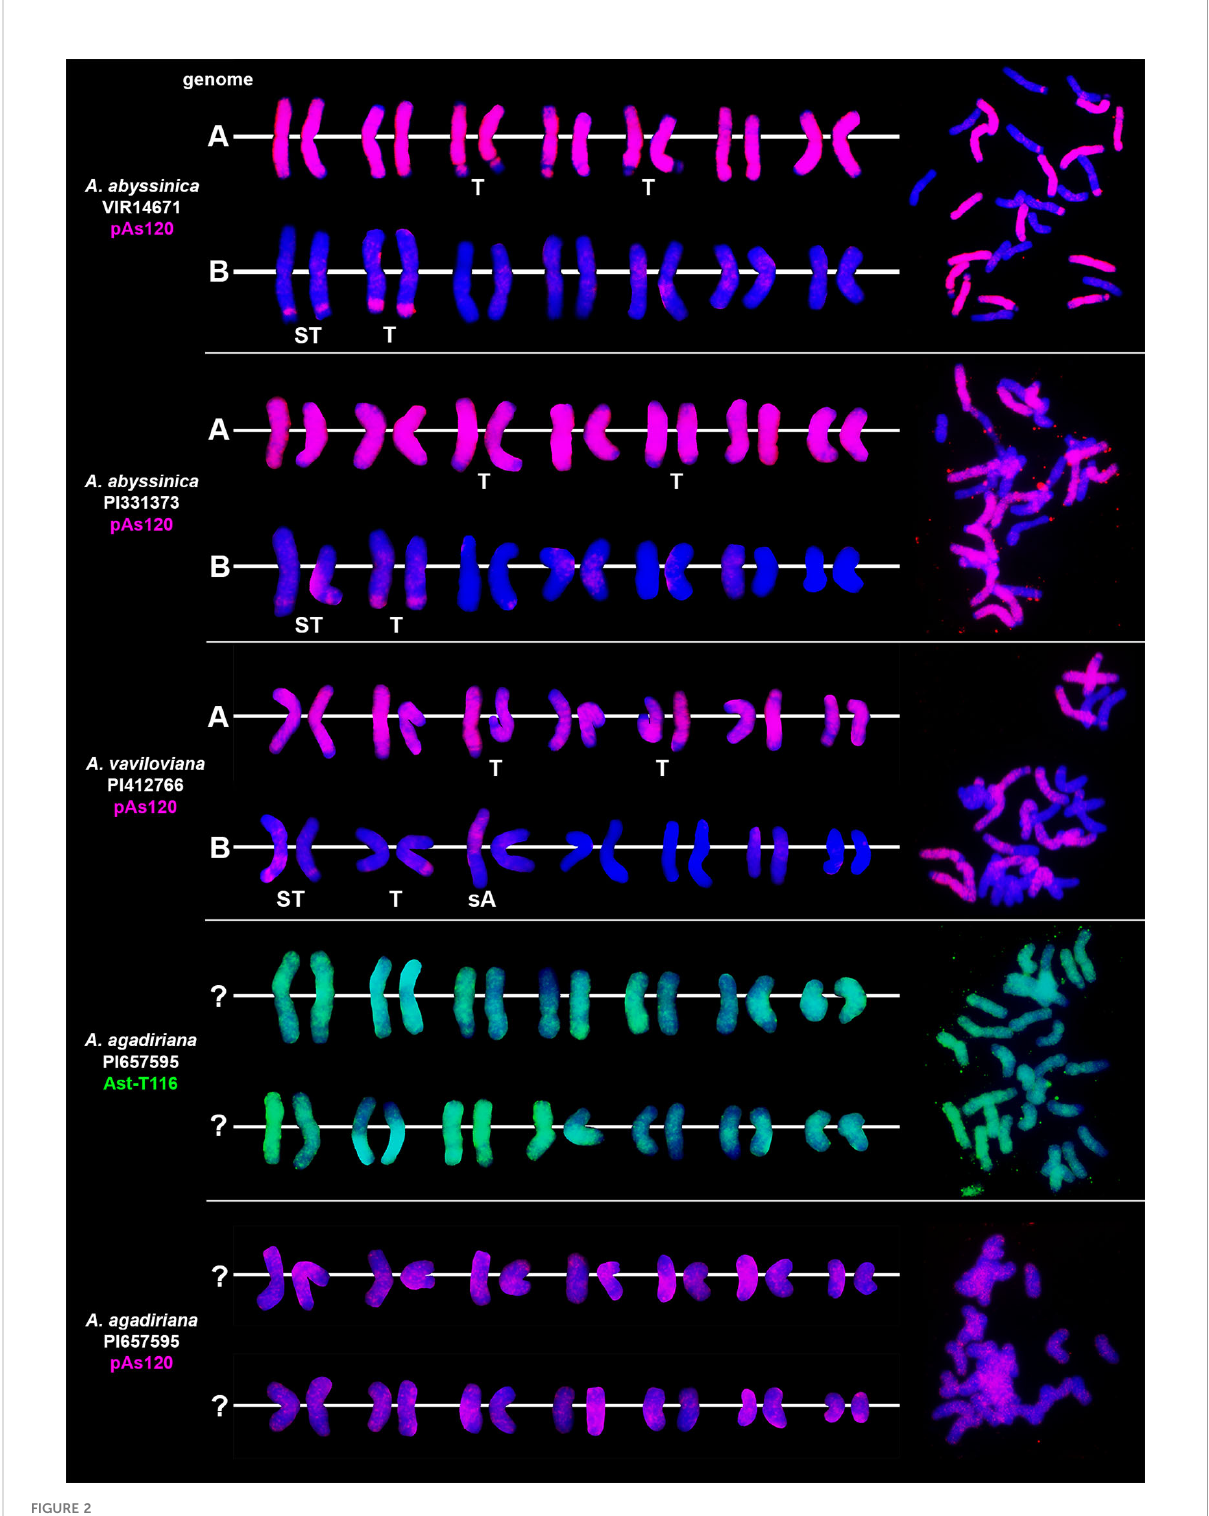
FIGURE 2 Genome composition and intergenomic translocations pattern in tetraploid oat species belonging to AABB Avena group. D- distal translocation, I- interstitial translocation, A - translocation of whole arm. Scale bar = 10 m